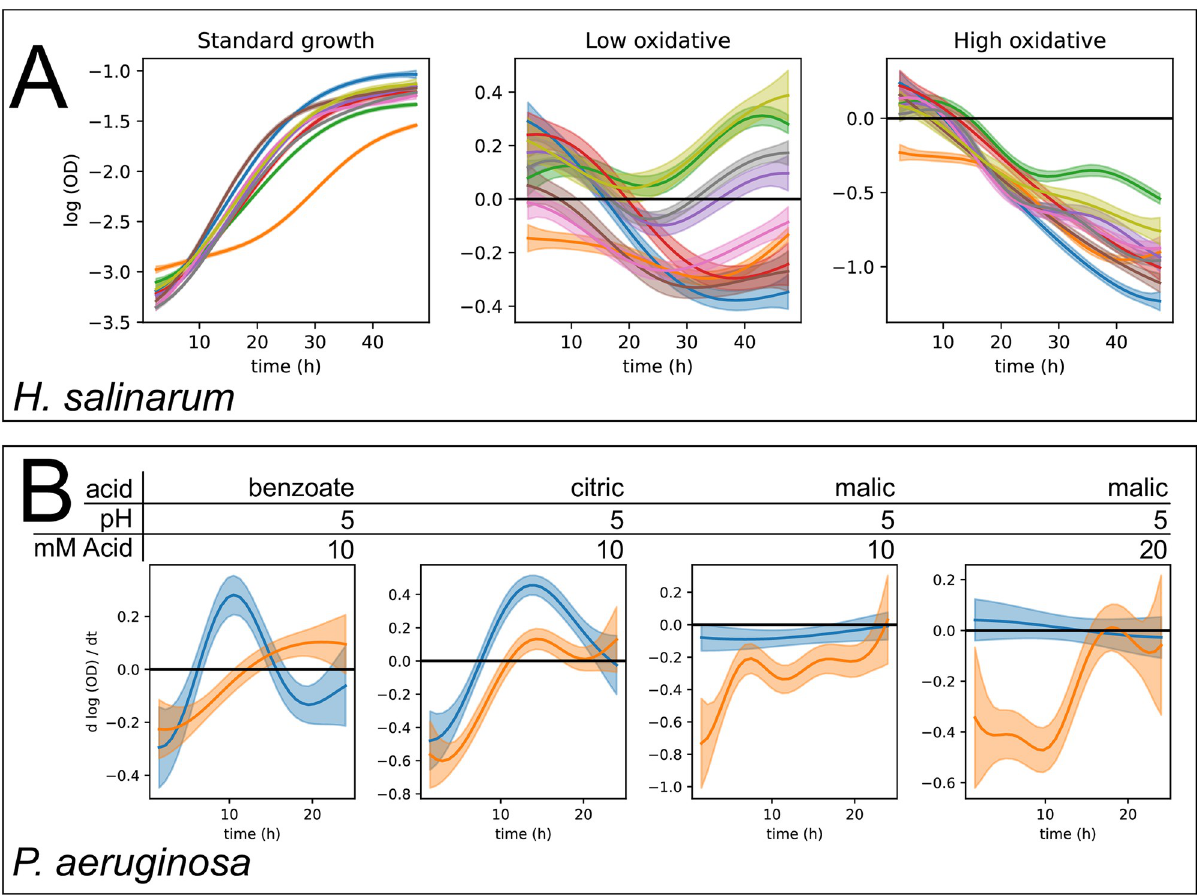
Fig 4. M null model estimates are confounded by batch effects. Posterior intervals of functions are shown for different analyses where phenom M null was fit using data from each batch separately. In all plots, solid line represents posterior mean, shaded region indicates 95% credible region, and each color corresponds to a different posterior conditioned on data from a single batch. (A) Posterior intervals of m ( t ) under standard growth, and δ ( t ) under low and high OS response for H. salinarum . (B) Posterior interval of interaction function ( αβ ) p , c ( t ) for P. aeruginosa growth in indicated pH and acid